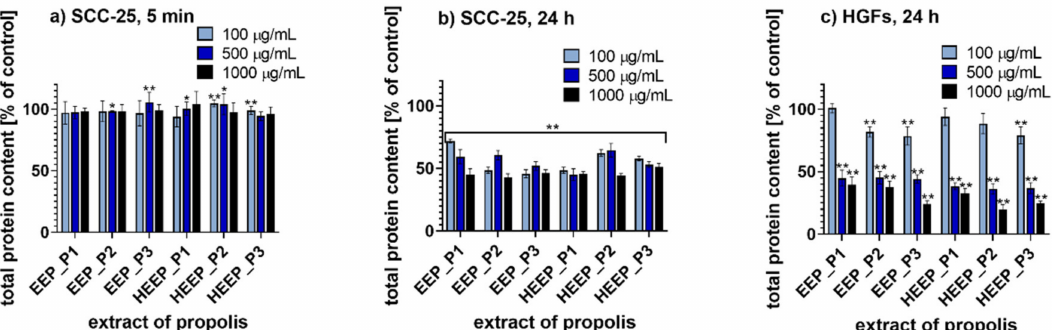
Figure 3. Sulforhodamine B (SRB) assay results for: ( a ) tongue cancer cells (SCC-25) incubated for 5 min with propolis extracts; ( b ) tongue cancer cells (SCC-25) incubated for 24 h with propolis